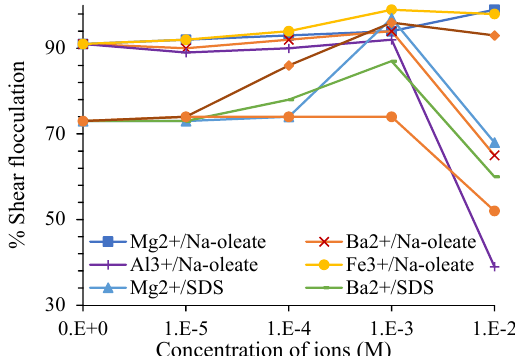
Figure 8. Effect of multivalent ions on the shear flocculation of colemanite with 60 mg/L of collector at pH 11.5 [13].